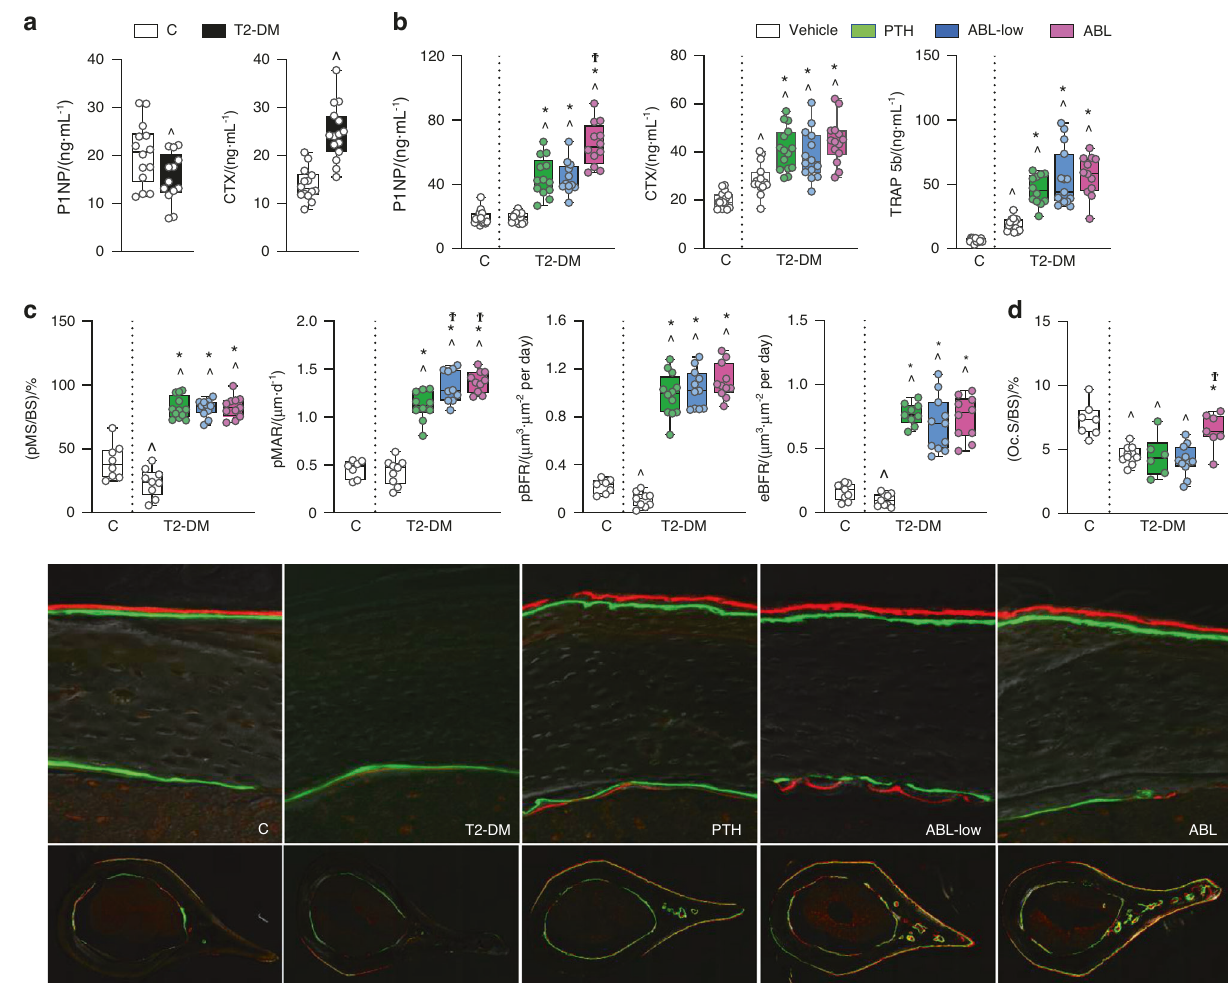
Fig. 3 PTH and ABL reversed the impaired osteoblast function in diabetes, but ABL was more potent. Serum P1NP and CTX measure a before (t3) and b P1NP, CTX, TRAP5b measure after (t4) treatment with PTH or ABL. c Dynamic bone histomorphometric analysis of periosteal mineralized surface/bone surface (MS/BS) and mineral apposition rate (MAR) and periosteal and endosteal bone formation rate (BFR) of the cross-section of the femoral mid-diaphysis and representative images. d Surface covered by osteoclasts (OcS/BS). n = 12 – 15 mice per group. Data are presented as box & whisker plot where each dot represents a mouse. ^ P < 0.05 versus C mice by unpaired and two-tailed Student ’ s t-test ( a ) or one-w a y ANOVA with post hoc Dunnet ’ s correction ( b – d ); * P < 0.05 versus T2-DM mice treated with vehicle and Ϯ P < 0.05 versus T2- DM mice treated with PTH by one-way ANOVA with post hoc Tukey ’ s